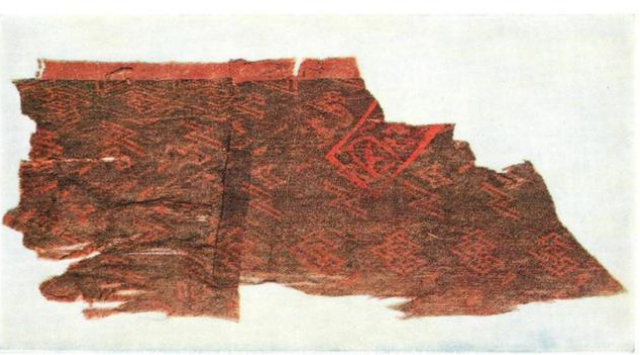
Figure 1. Remnant of a square brown brocade unearthed from the Zuojiatang Chu tomb in Chang- sha.